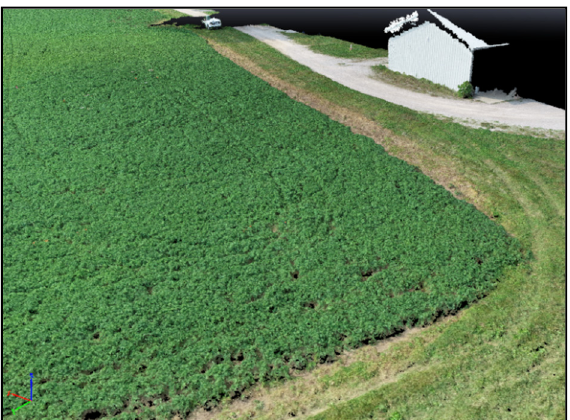
Figure 4. An isometric top view of a portion of a fully processed alfalfa model of field 1 flown on 4 June 2019 using 30–90° flight parameters. Only part of the nearby barn is modeled as the flights only recorded one side of the building.